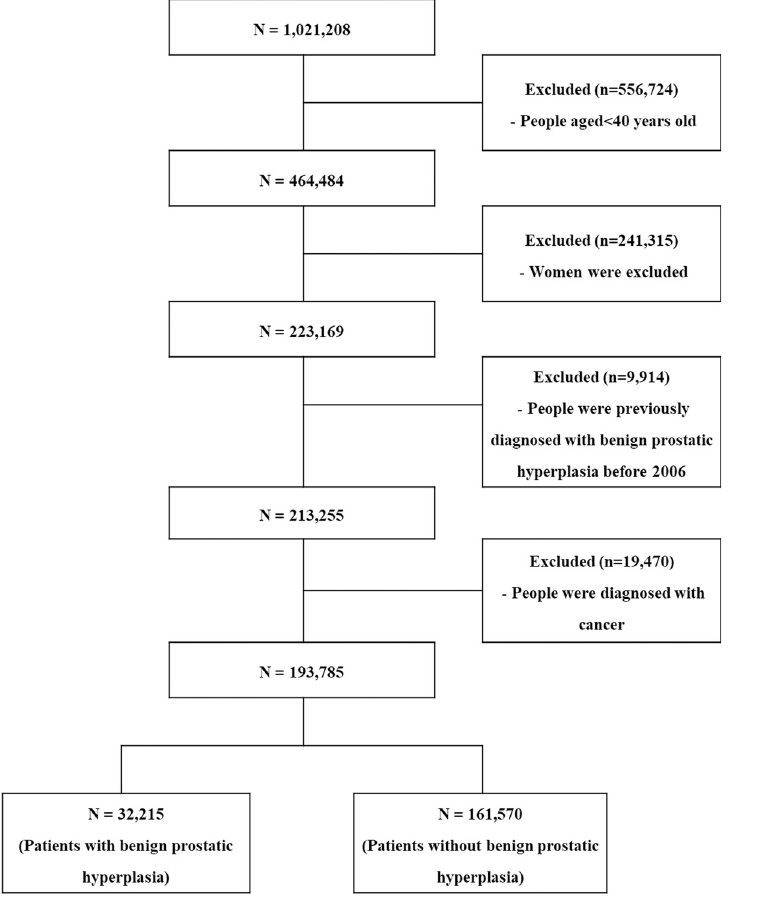
Fig 1. Flow-chart for selection of study